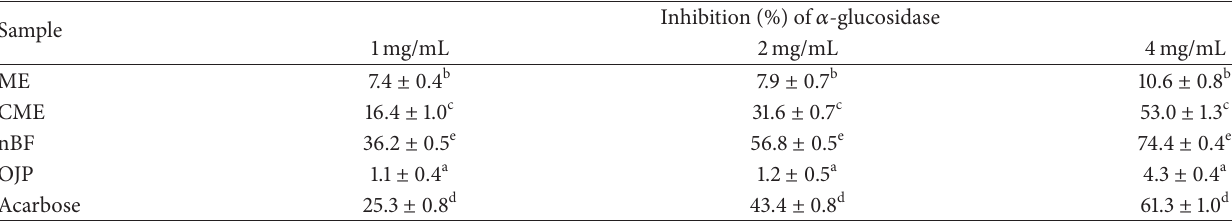
Table 6: 𝛼 -glucosidase inhibitory activity of O. japonicus tubers extracts. Sample